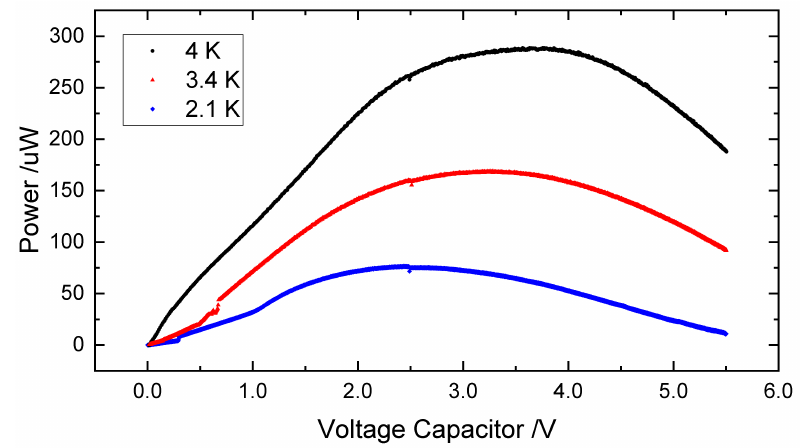
Figure 5. Measured charging power for different temperature differences directly applied to the two connected TEGs in the lab. Only the power-management circuitry (see Figure 4) is used. At 2.5V, a slight power dip can be seen at which the step-down converter is turned